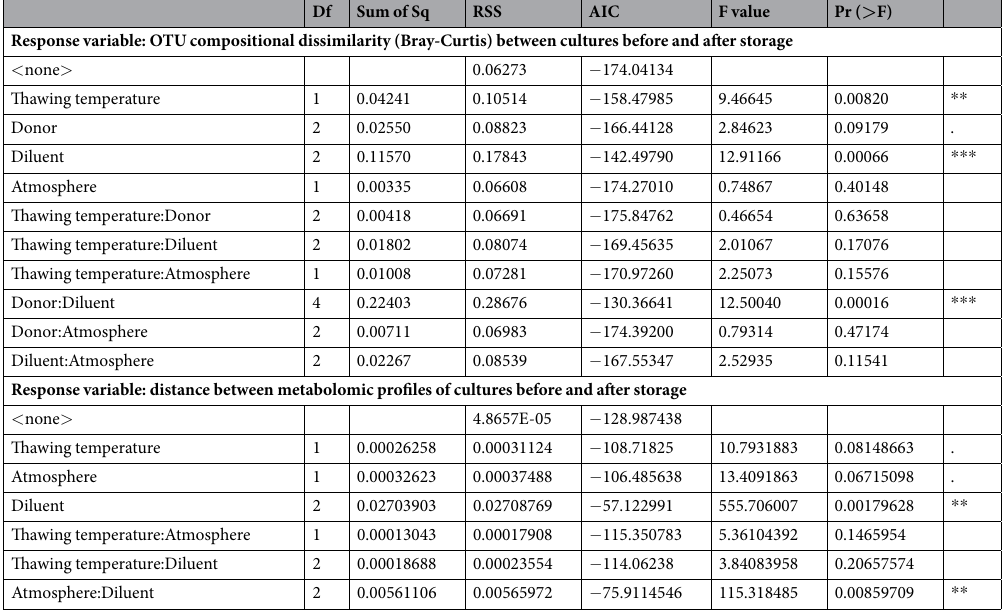
Table 3. Results of the two-way ANOVA. Innovative conservative diluents and thawing conditions. Signif. codes: 0 ‘ *** ’ 0.001 ‘ ** ’ 0.01 ‘ * ’ 0.05 ‘.’ 0.1 ‘ ’